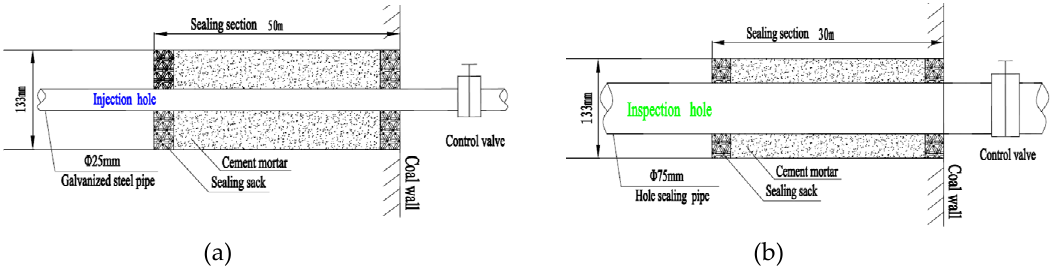
Figure 6. The sealing lengths of injection hole and inspection hole ( a ) The sealing length of injec- tion hole and ( b ) The sealing length of inspection hole.